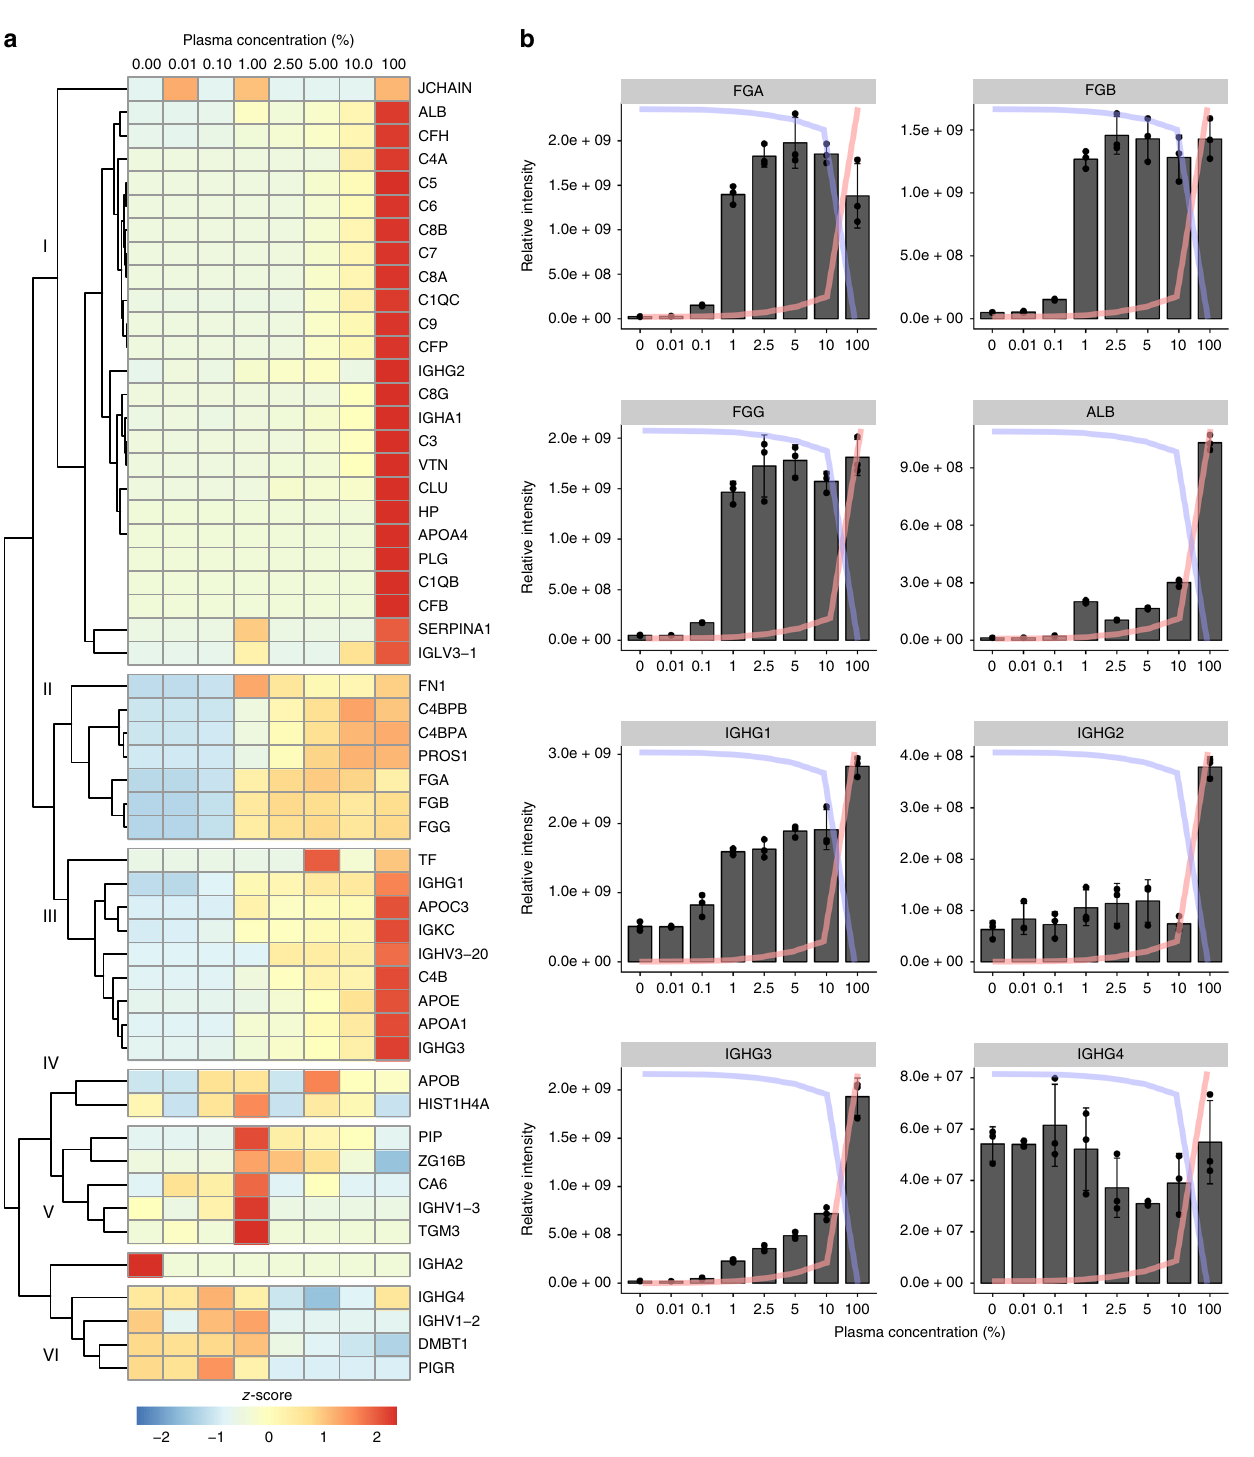
Fig. 3 SA – DIA in a mixed plasma – saliva environment. Different mixtures of plasma in saliva (0.01%, 0.1%, 1%, 2.5%, 5%, and 10% plasma) were used to study the effect of host environment on protein – protein interactions. a Cluster analysis of the SA – DIA data with the M1 serotype S. pyogenes strain AP1 in a mixed plasma and saliva environment based on z -score. b SA – DIA interaction patterns of fi brinogen, albumin, and the different IgG subclasses in mixed plasma and saliva environments in n = 3 biologically independent samples. The y -axis represents relative intensity and x -axis plasma concentration (%) in panel b . The graph overlaid blue lines represent relative saliva concentration and the red lines relative plasma concentration in a given sample. Error bars are expressed as standard deviation (s.d.) from the mean. Source data are provided as a Source Data fi